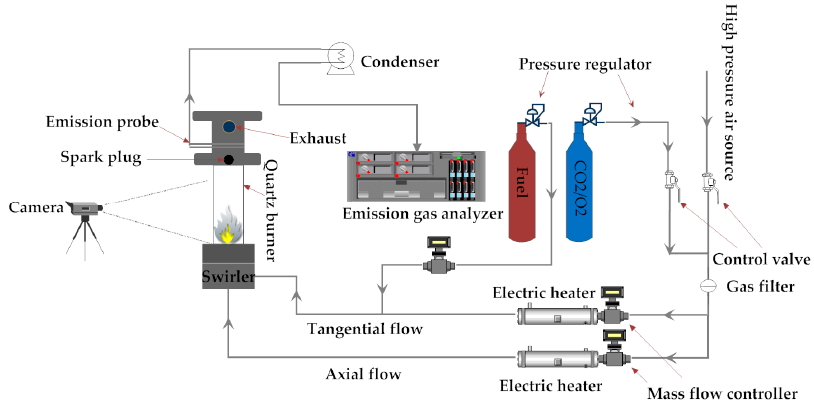
Figure 1. Layout of the experimental facilities.